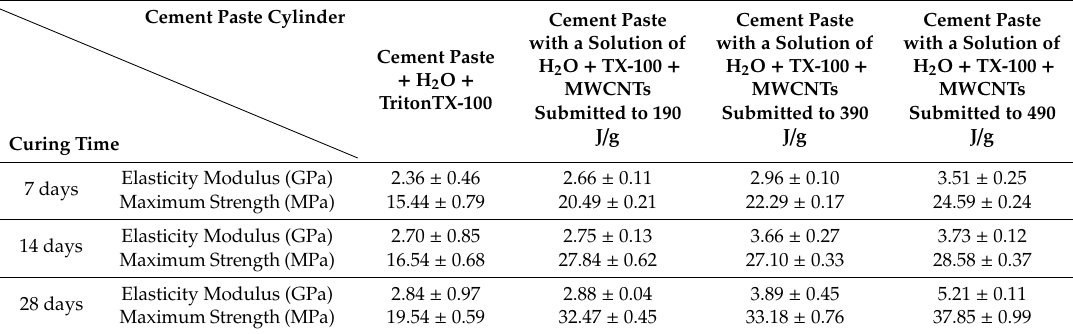
Table 2. Summary of results from quasi-static compression tests on Portland cement specimens performed with an MWCNTs solution at one repose week.